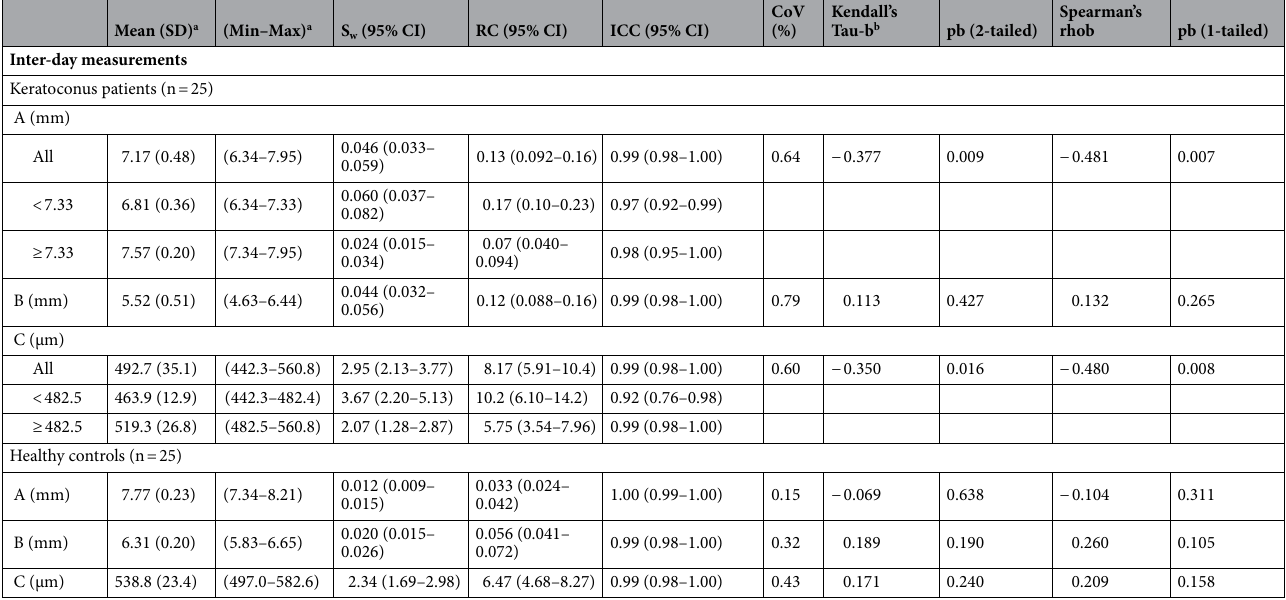
Table 3. Descriptive statistics and repeatability of inter-day Pentacam measurements in subjects with keratoconus and healthy controls (mean of replicates). A = Anterior curvature of the 3 mm zone over the thinnest point (mm). B = Posterior curvature of the 3 mm zone under the thinnest point (mm). C = Thickness of the thinnest point on the cornea (μm). a Subject mean. b Subject SD versus subject